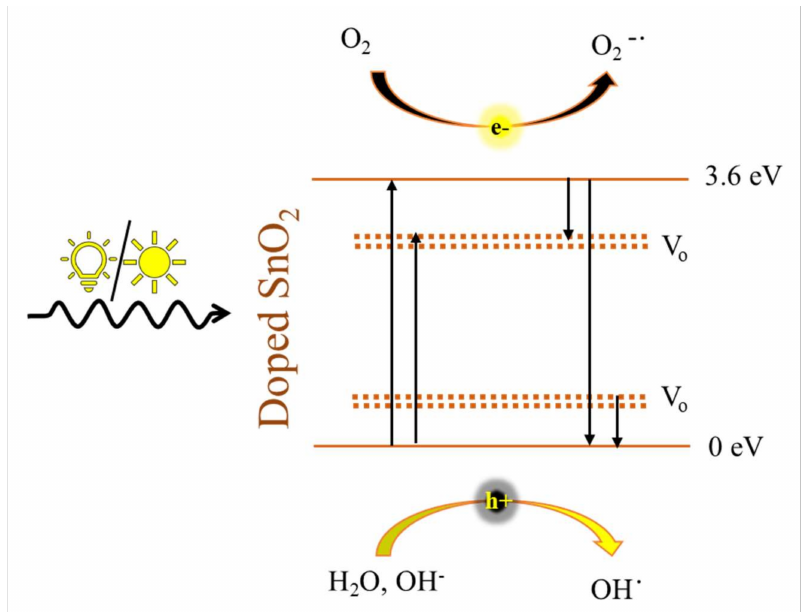
Figure 6. Illustration of the influence of oxygen vacancies in the energy levels and the excitation of the electron during the photocatalytic activity of doped SnO 2 . Adapted from reference [2]. Copyright 2020 Faculty of Technology, University of Novi Sad.